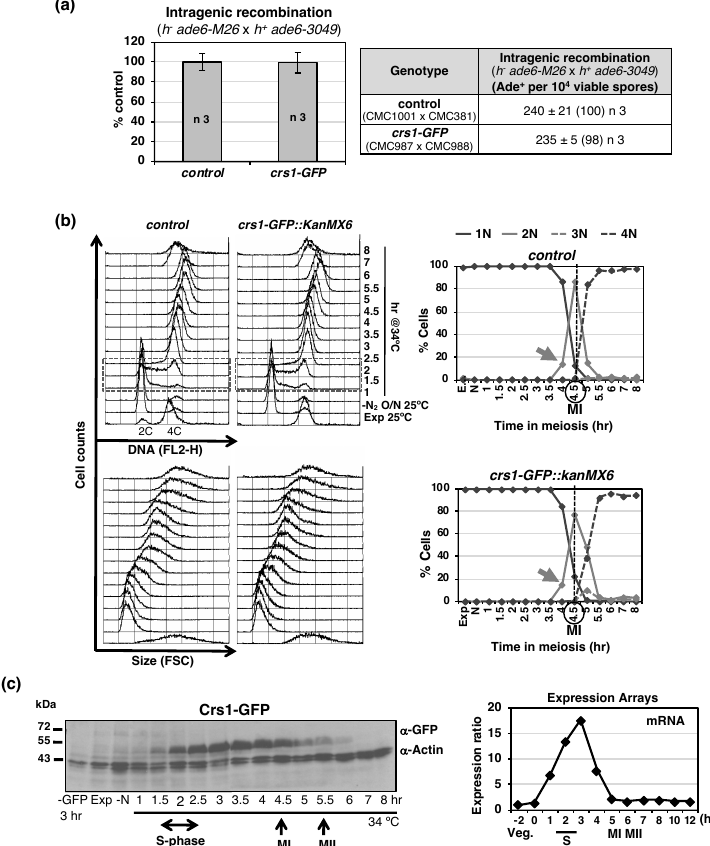
Figure 1. Crs1-GFP functionality and expression. ( a ) Recombination assays showing that Crs1-GFP is proficient for recombination. Crosses of h − ade6-M26 x h + ade6-3049 in MEA were performed and plated for recombinant frequency twice. Table shows gene conversion (intragenic recombination) expressed as the mean of Ade + per 10 4 viable spores +/ − SEM of 3 independent crosses based on the cumulative number of spore colonies in each cross; 168–294 Ade + colonies scored in each independent cross. The numbers in parentheses are percentages relative to wild-type control. Strains used in the crosses are indicated. Graph shows same data as mean of the percentage relative to the control cross +/ − SEM. ( b ) Flow cytometry analysis of synchronous meiosis of diploid pat1-114 control (CMC1074) and pat1-114 crs1-GFP (CMC1000) cells. DNA content (FL2-H) and Size (FSC) histograms are shown. Dashed-lined box outlines S-phase progression. On the right: Quantification of chromosome segregation by DAPI staining and nuclear counting (1 nucleus, 2 nuclei, 3 nuclei, and 4 nuclei) is shown. The arrows indicate meiosis I (MI) entry, and the vertical dashed-lines indicate the peak of MI. ( c ) Crs1-GFP protein expression during synchronous diploid pat1-114 meiosis (CMC1000). Same blot was sequentially used with anti-GFP and anti-Actin antibodies. On the right, mRNA expression levels during synchronous diploid pat1-114 meiosis (microarrays data from